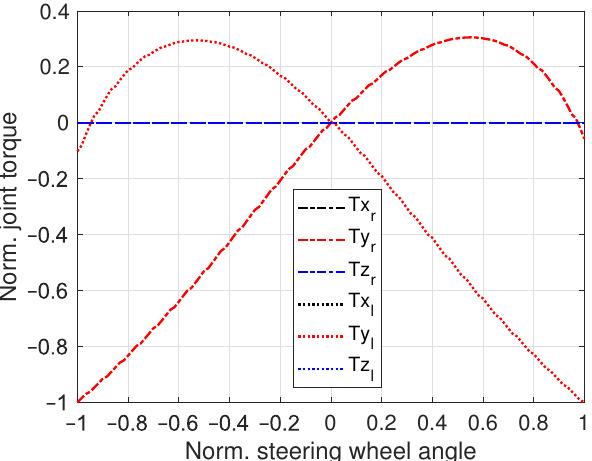
Figure 7. Normalized shoulder joint torques over normalized steering wheel angle.